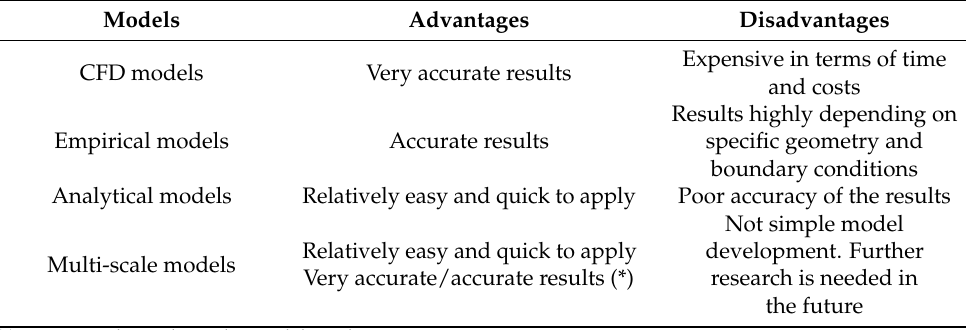
Table 1. Summary of design methods with the indication of advantages and disadvantages. Models Advantages Disadvantages Expensive in terms of time CFD models Very accurate results Results highly depending on Empirical models Accurate results specific geometry and Analytical models Relatively easy and quick to apply Poor accuracy of the results Not simple Relatively easy and quick to apply Multi-scale models